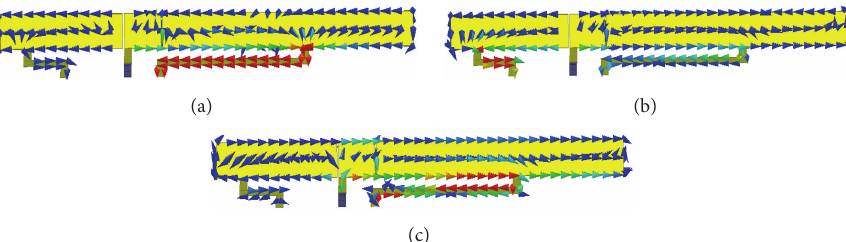
Figure 6: Simulated surface current distributions. (a) 870 MHz: ZOR by big mushroom. (b) 1750 MHz: ZOR by small mushroom. (c) 2000 MHz: loop resonance by big mushroom.